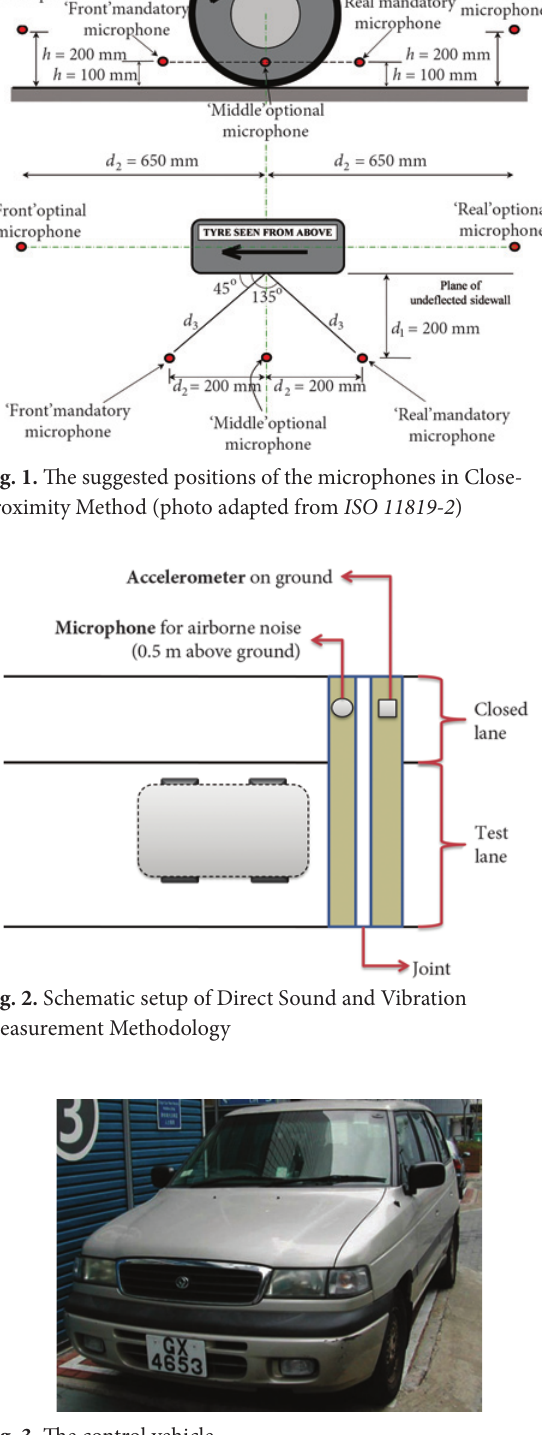
Fig. 3. The control